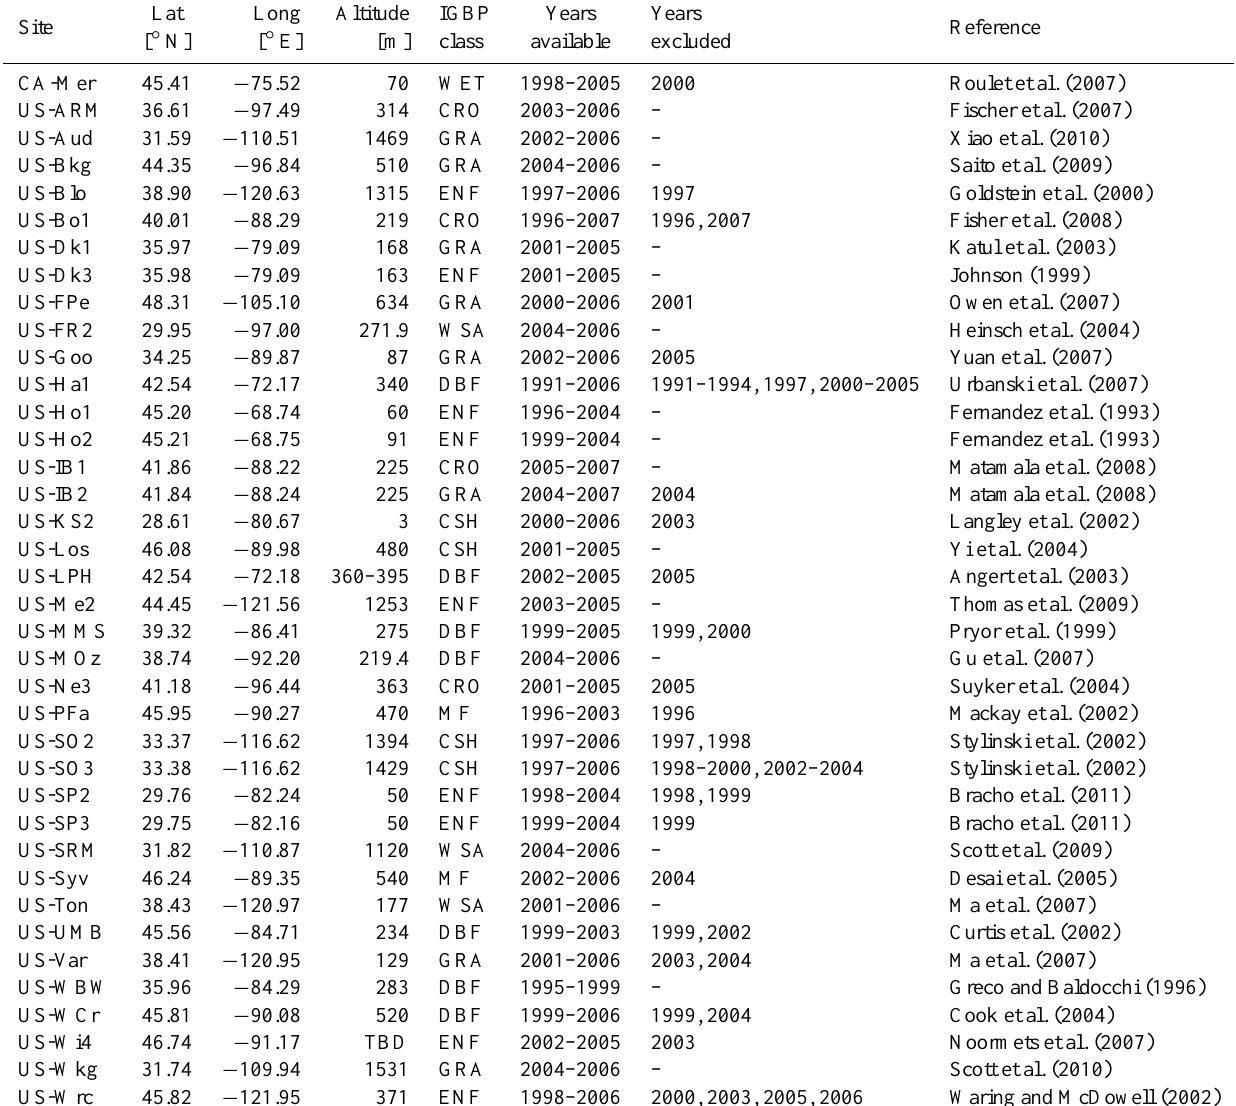
Table 1. FLUXNET sites included in this study, with latitude, longitude, altitude, vegetation class (IGBP, International Geosphere-Biosphere Programme), years available, years excluded from the analysis, and reference publication. IGBP classes represented in this subset of sites are croplands (CRO), closed shrublands (CSH), deciduous broadleaf forests (DBF), evergreen needleleaf forests (ENF), grasslands (GRA), mixed forests (MF), permanent wetlands (WET), and woody savannas (WSA). For a detailed description of the vegetation classes,